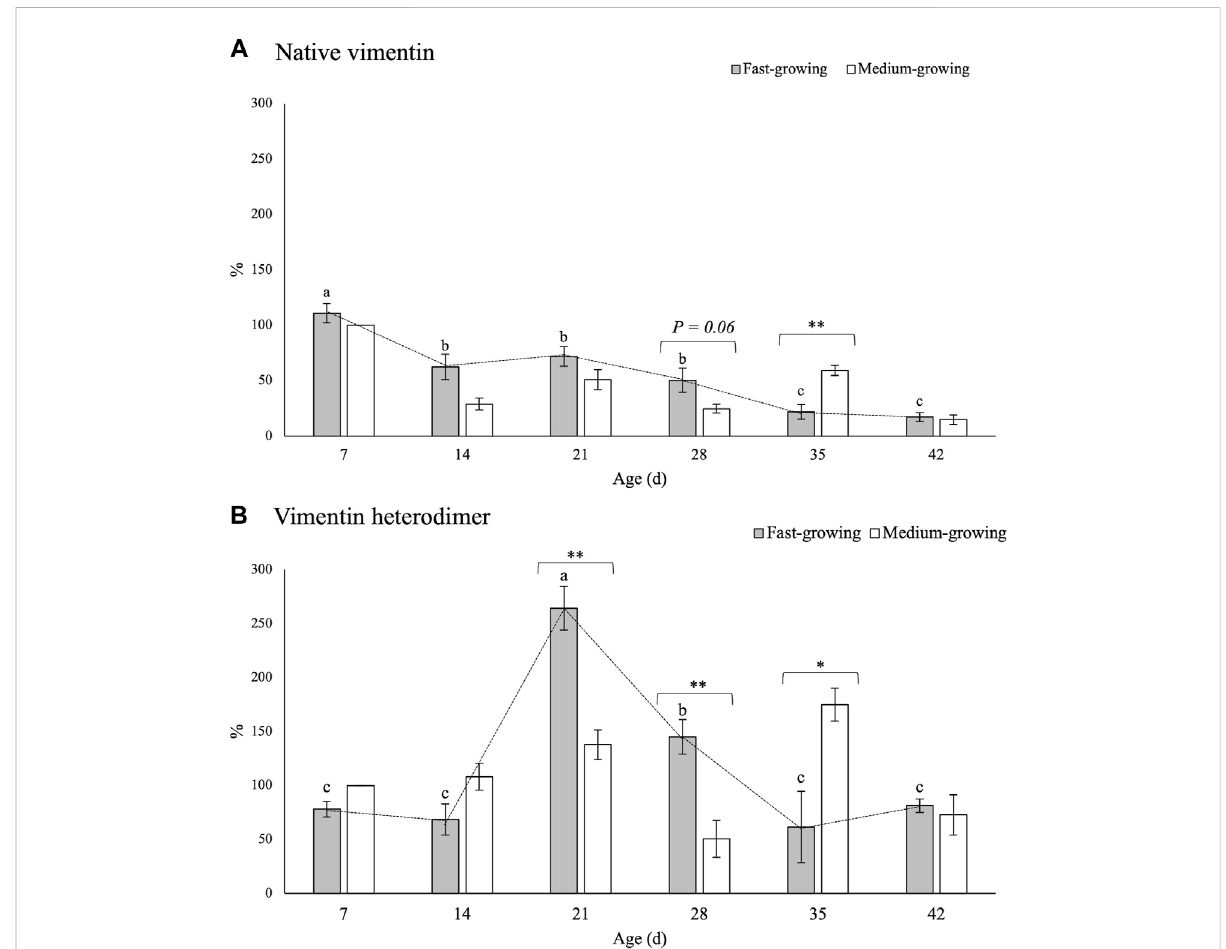
FIGURE 4 Relativeconcentrationsofnativevimentin (A) andofitsheterodimericform (B) in Pectoralismajor musclesofbroilerchickensbelongingtofast- and medium-growing genotypes at different ages. The results are expressed as %, considering as 100% the intensity of the band in MG at the beginning of the rearing period (day 7 – d 7). Error bars indicate standard error of mean. Within the same age (7, 14, 21, 28, 35, and 42 days) data were analyzed by using the non-parametric Mann-Whitney U test to investigate the effect of the genotype (FG vs. MG). * and ** = within the same age, mean values signi fi cantly differ between FG and MG for a p -value < 0.05 and < 0.01, respectively. On the other hand, the evolution ofvimentin in FG over their growth period was assessed by One-way ANOVA. a-c = for FG, mean values followed by different letters signi fi cantly differ over the growth period ( p <